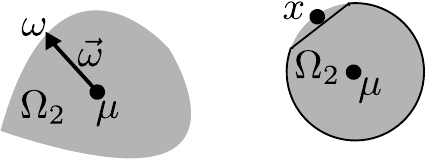
Figure 12: Left: The definition of Bloch vectors embeds the normalized states into a linear space (of one dimension less than the linear space on which the state cone lives). Right: If any point on the sphere does not correspond to a valid state, then this contradicts the strict convexity of Ω 2